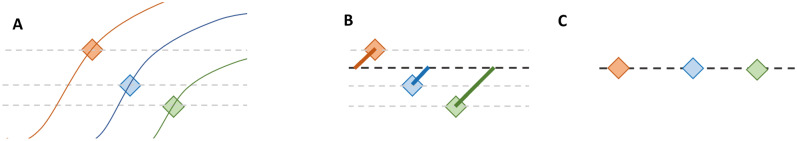
Methodological process behind variable fluorescence calculation. (A) During data collection, scientists utilize a portion of qPCR curve which best embodies the general shape of the curve for each analysis per gene – this graphic embodies three samples, each studying one (the same) gene. This does not have to occur at one single threshold. Note that in this workflow, all qPCR curves appear to be smooth, but this is not an accurate assumption for all runs. (B) Transition: data points are reevaluated (mathematically) to a single fluorescence threshold (using threshold consolidation method). (C) Analysis: comparative Ct analysis occurs on dataset, which now provides Ct values at one threshold (per gene).